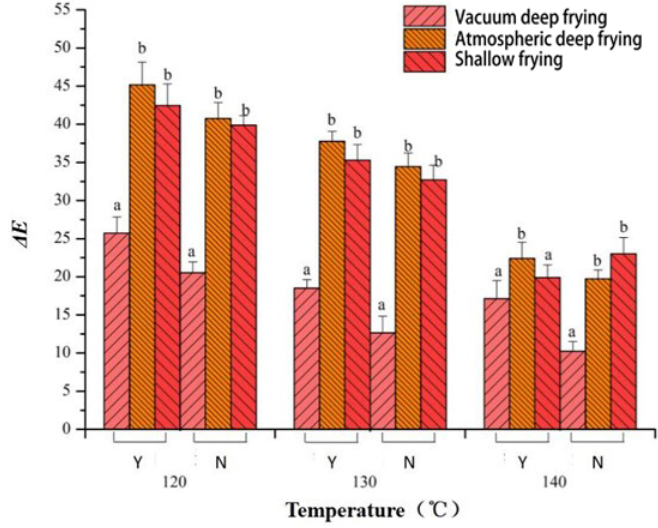
Figure 5. Effect of different temperatures on color difference of surimi cubes with different frying technologies (Y: radish added; N: no radish). Different letters in the same chart represent significant differences between different treatments according to Duncan’s multiple range test. ( p < 0.05).